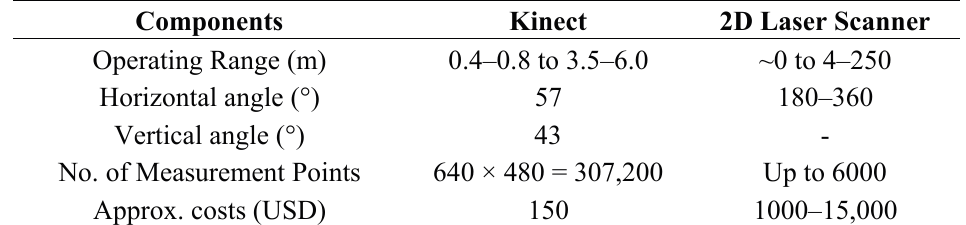
Table 1. Technical specifications of Kinect’s depth camera as compared to a laser scanner which is typically used in robotics applications, particularly